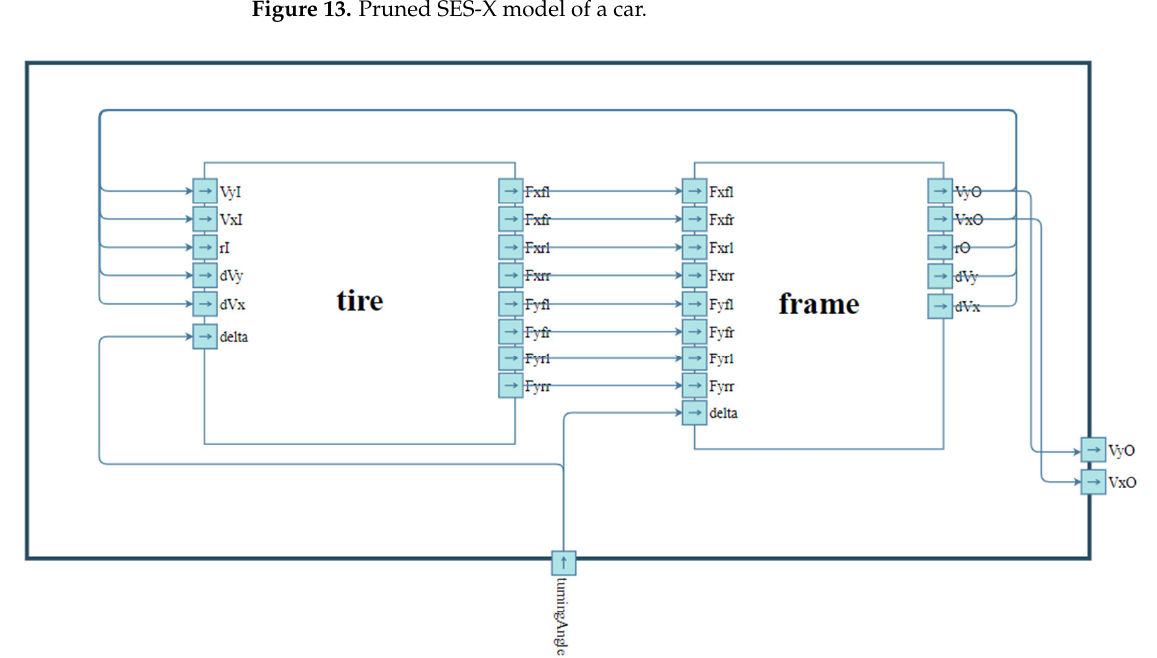
Figure 14. Car model connecting the frame with tires in X